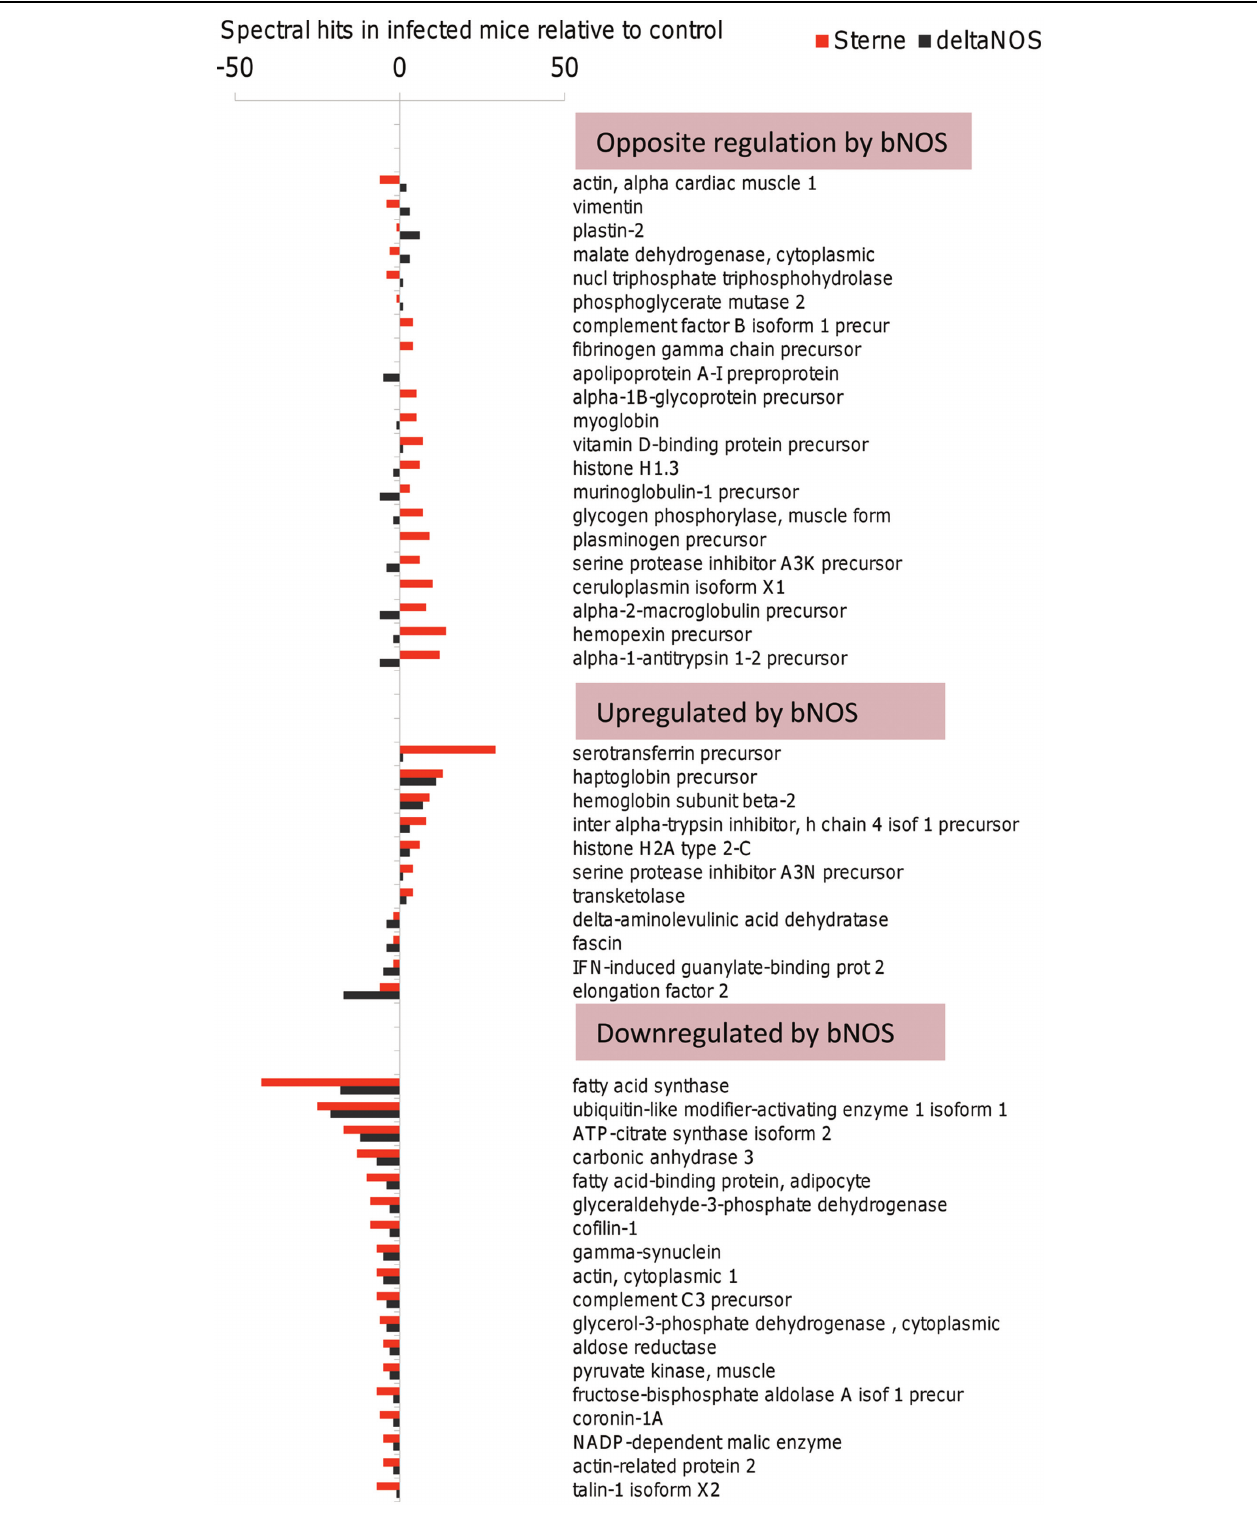
FIGURE 7 | Sterne and (cid:2) NOS infections lead to the homeostatic imbalance of lymph proteins. The responses which differed by three or more hits relative to uninfected control were grouped into three clusters representing the responses (i) opposite to each other between Sterne and (cid:2) NOS strains, (ii) enhanced by bNOS-expressing Sterne, and (iii) downregulated by bNOS-expressing Sterne relative to (cid:2) NOS.